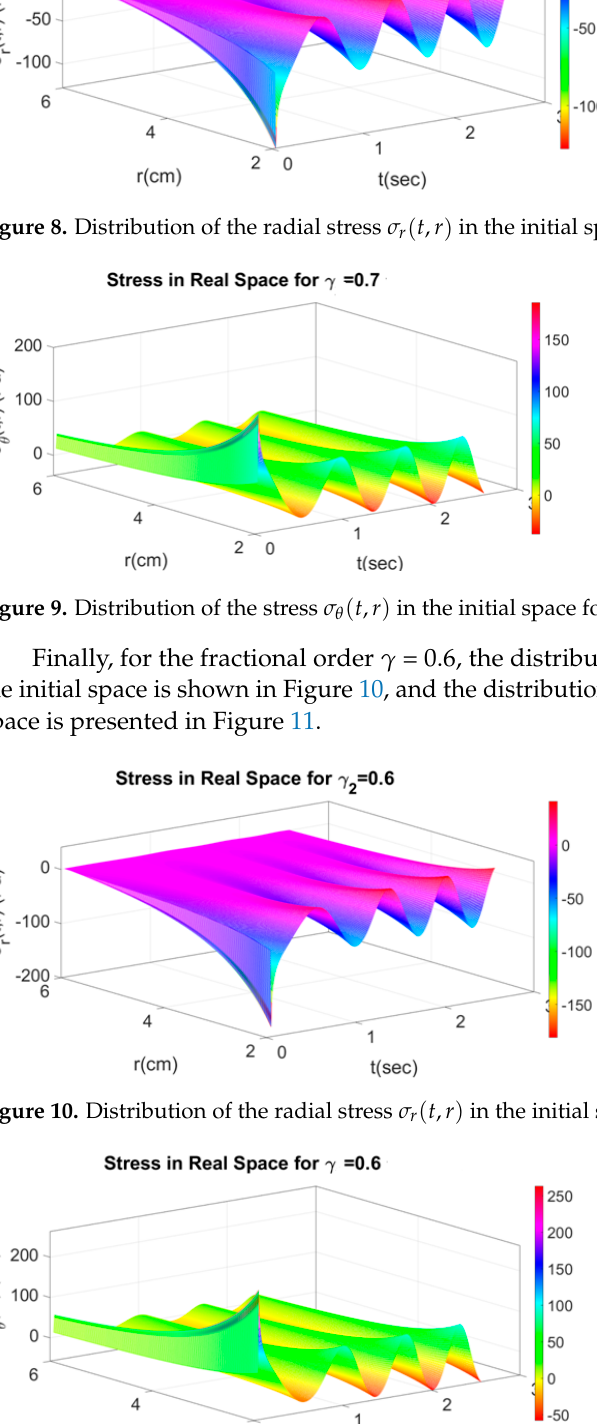
Figure 7. Distribution of the stress 𝜎 (cid:3087) (𝑡,𝑟) in the initial space for γ = 0.8.